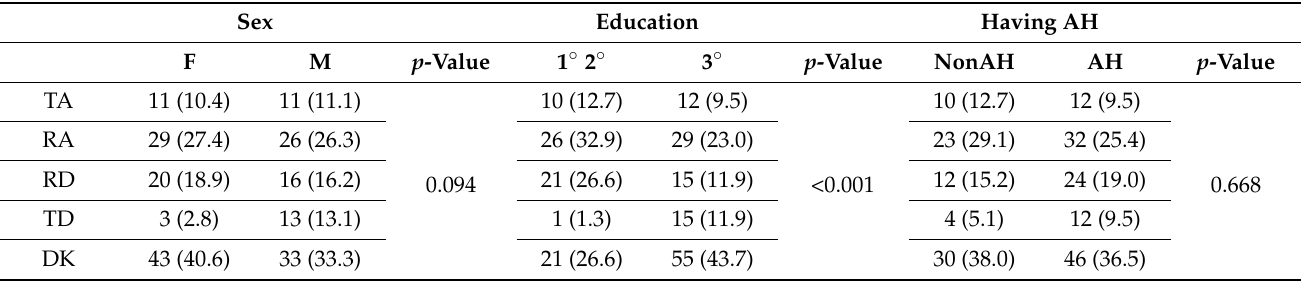
Table 14. Noise as a factor that increases the incidence of hypertension by gender, education, and having hypertension (N =